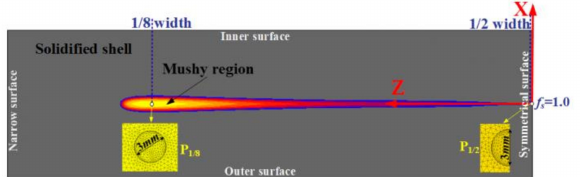
Figure 4. Solidification morphology of the wide-thick slab transverse section when solid phase fraction ( f s ) at the slab center reaches 1.0, and the distribution of the two artificial porosities on slab the transverse section in the 3D thermal mechanical